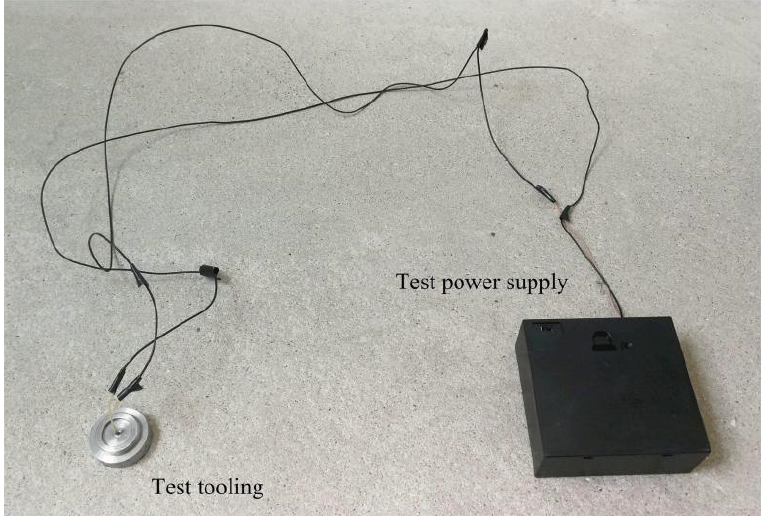
Figure 22. Pin pusher test tooling.